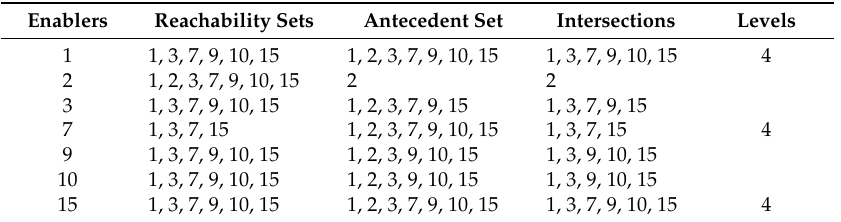
Table 9. Level partitions for enablers—Iteration